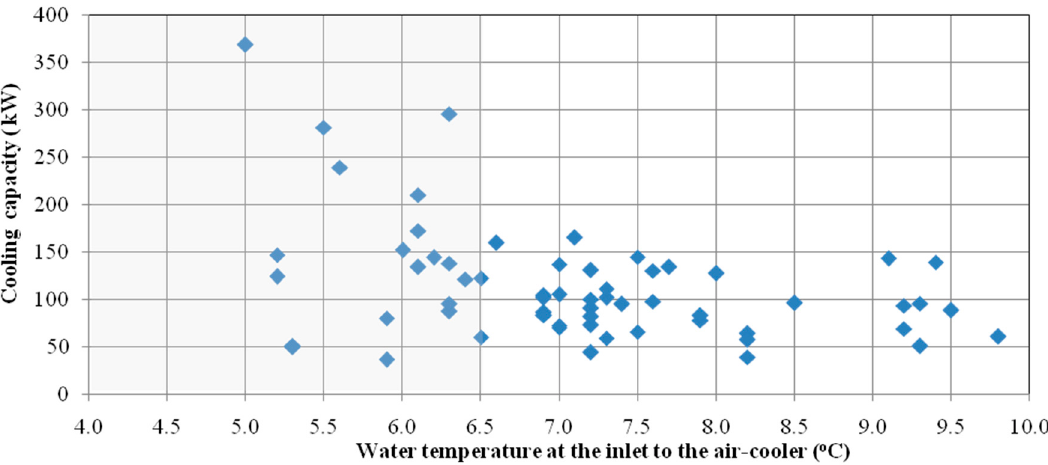
Figure 9. The relationship between the cooling capacity and the water temperature at the inlet to the spot air-coolers.